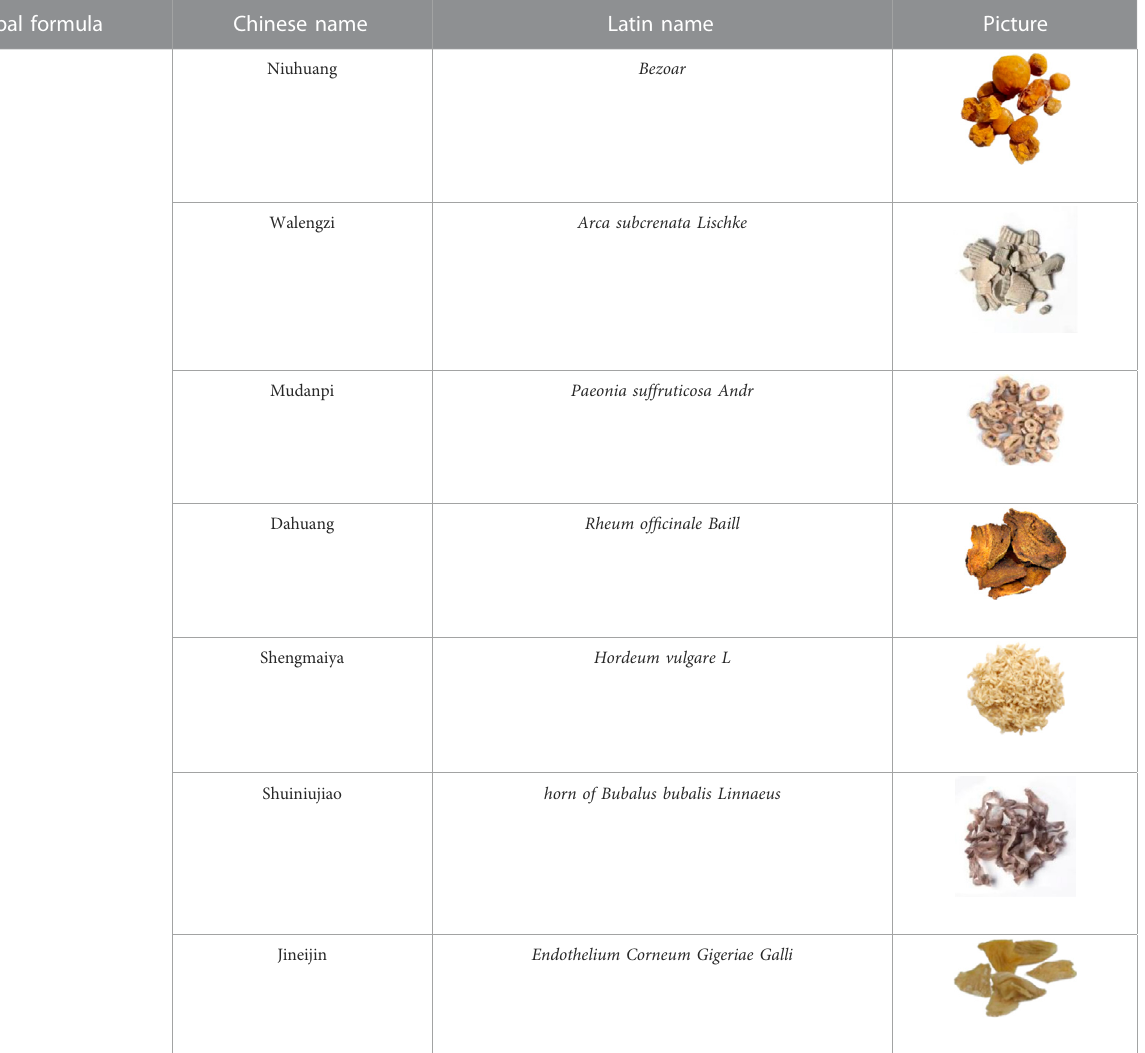
FFBJRG, while Sanqi ( Panax notoginseng (Burkill) F. H. Chen) is an ingredient in ALHX and FFBJRG. The compositions of the anti- hepatic fi brosis herbal formulations are listed in Table